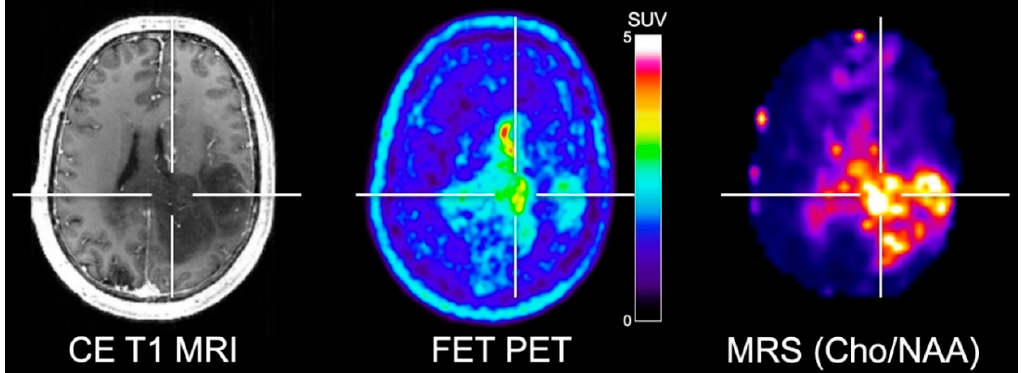
Figure 1. Simultaneously acquired contrast-enhanced (CE) T1-weighted MRI, FET PET and whole-brain MRS shows elevated choline/N-acetylaspartate (Cho/NAA) ratios in a patient with neuropathologically confirmed glioblastoma. Areas of contrast enhancement, FET uptake and increased Cho/NAA are spatially incongruent. Image courtesy of Joerg Mauler, Institute of Neuroscience and Medicine,